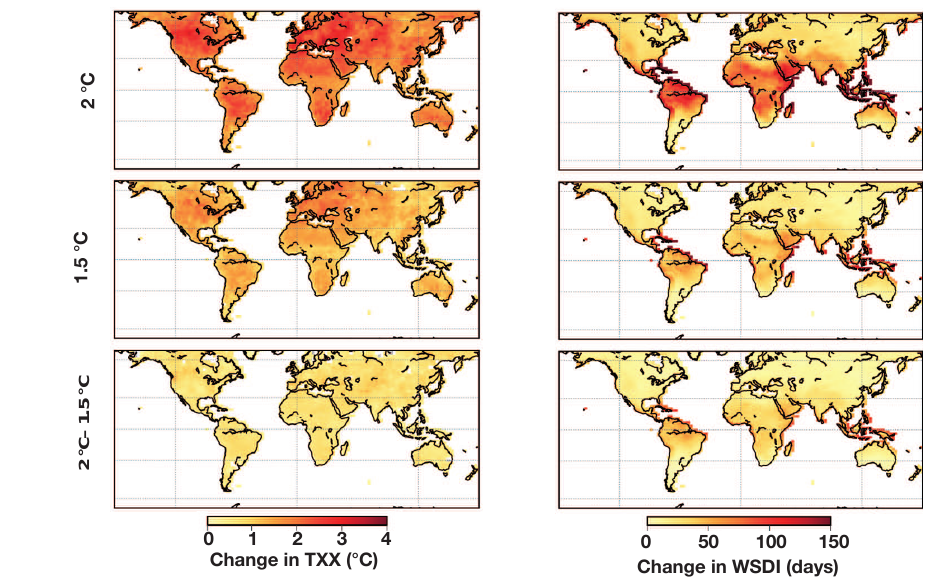
Figure 1. Median changes of TXx (left panels) and WSDI (right panels) for a warming of 2 ◦ C (upper panels), 1.5 ◦ C (middle panels) and the difference between the two warming levels (lower panels). Changes in TXx are given in ◦ C, whereas changes in WSDI are given in days.